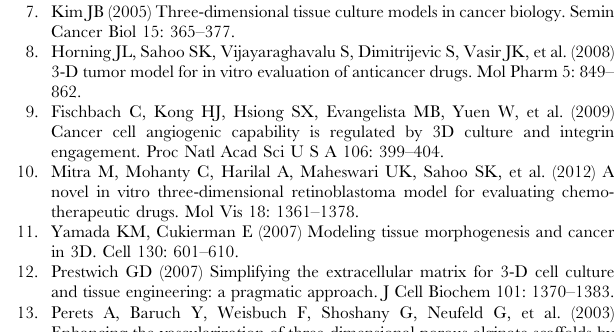
Table S1 Growth characteristics of H1650 cancer parental cells in 6 well plate format at 4 d, 9 d and 13 d post cell seeding with 015 and 0.25 million cells/ well. The average spheroid size, total spheroid number/well and total number of spheroids/plate. Each data point is represented as mean 6 sem (n= 3). Table S2 Growth characteristics of H1650 cancer stem cells in 6 well plate format at 4 d, 9 d and 13 d post cell seeding with 015 and 0.25 million cells/well. The average spheroid size, total spheroid number/well and total number of spheroids/plate. Each data point is represented as mean 6 sem (n=